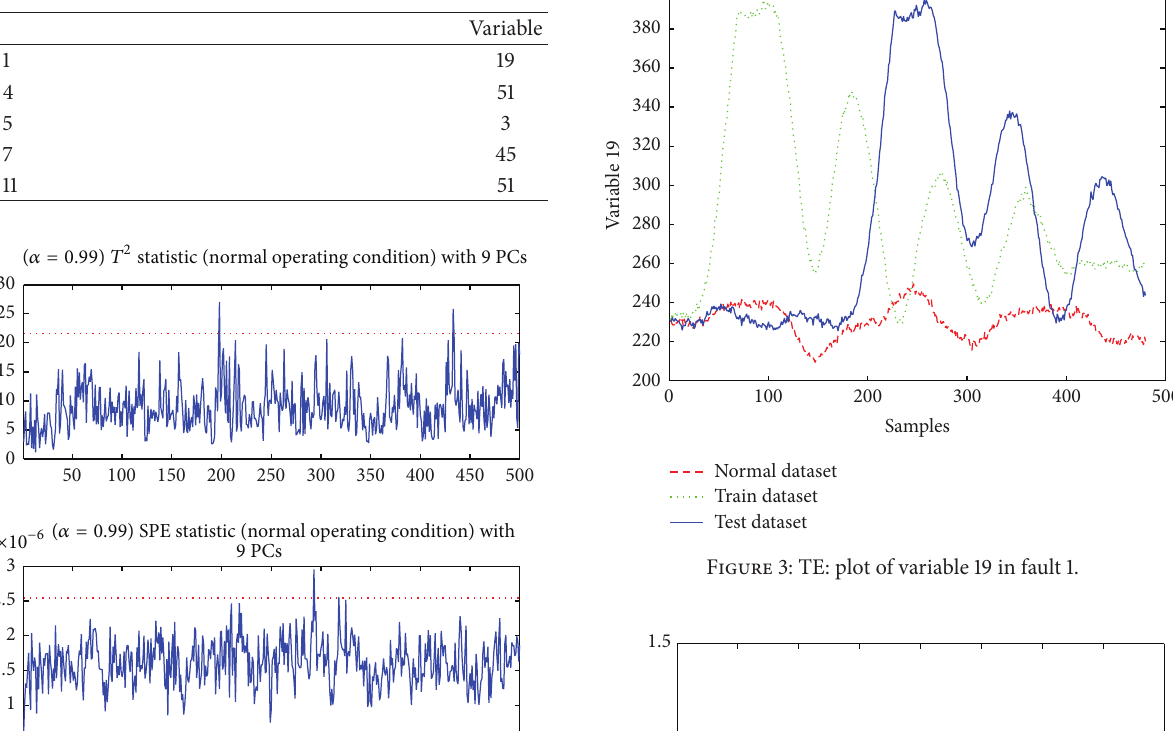
Table 1: The most relevant variable for each fault.